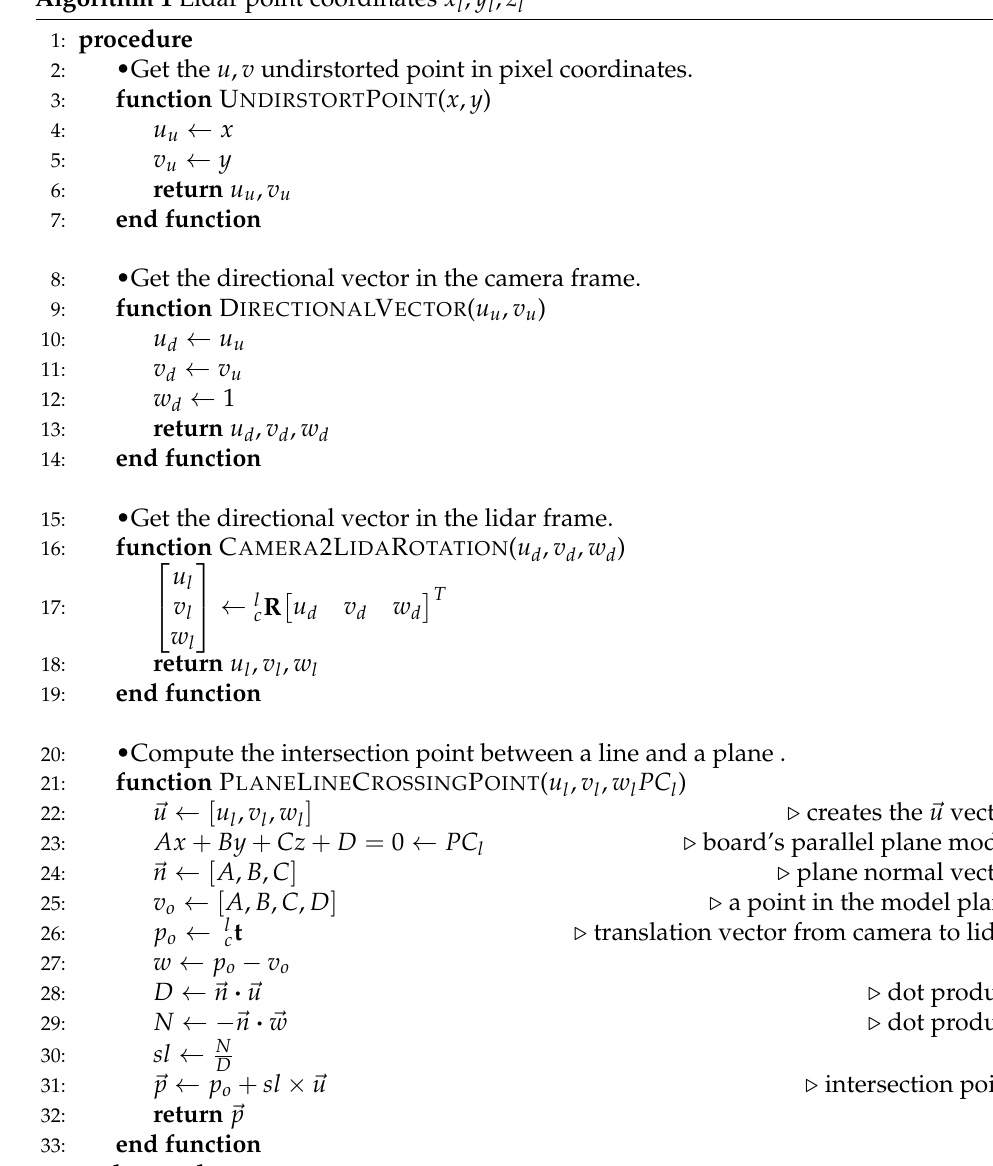
Algorithm 1 Lidar point coordinates x l , y l , z